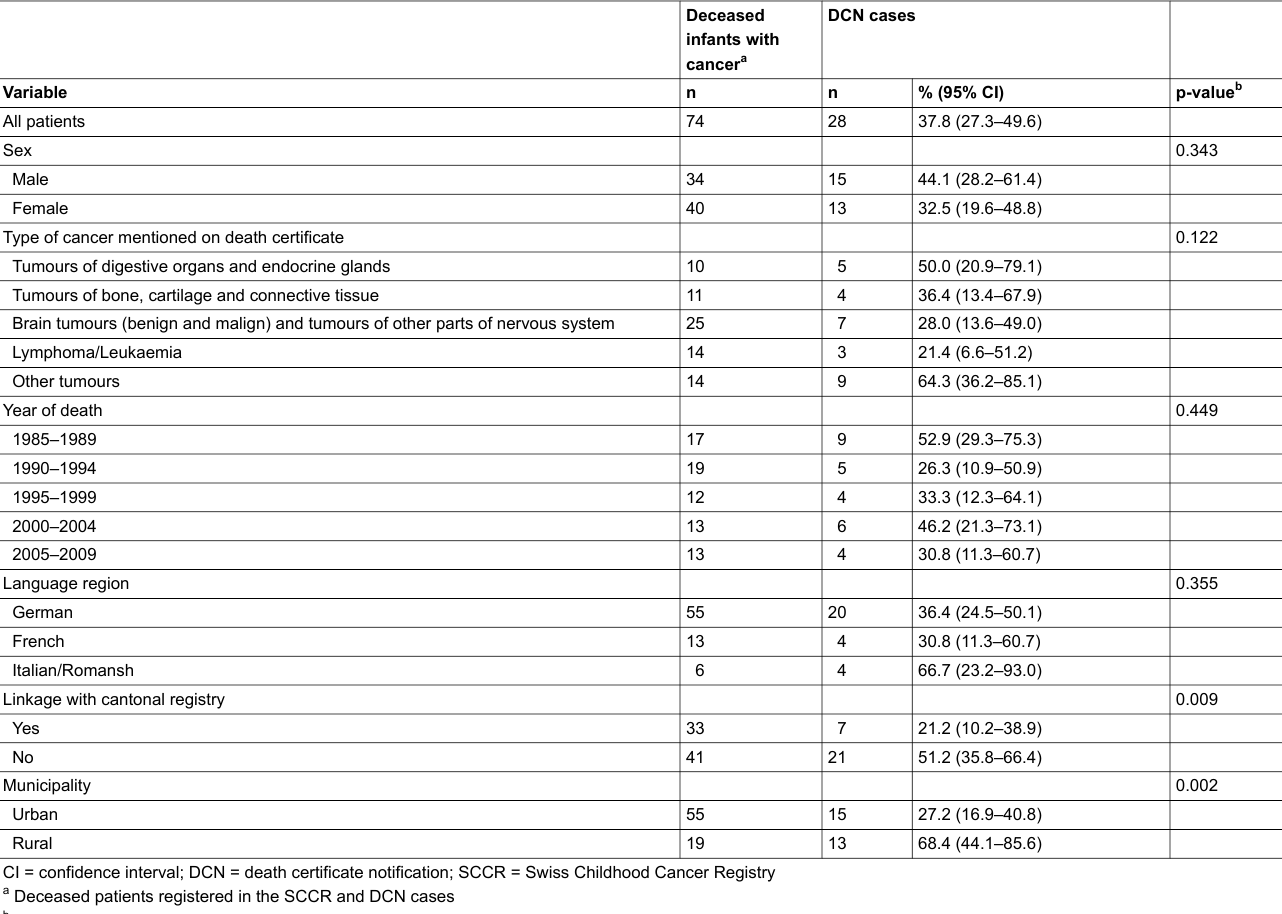
Table 3: Characteristics of infant cancer cases identified via death certificate notification.